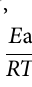
Frontiers in Energy Research |